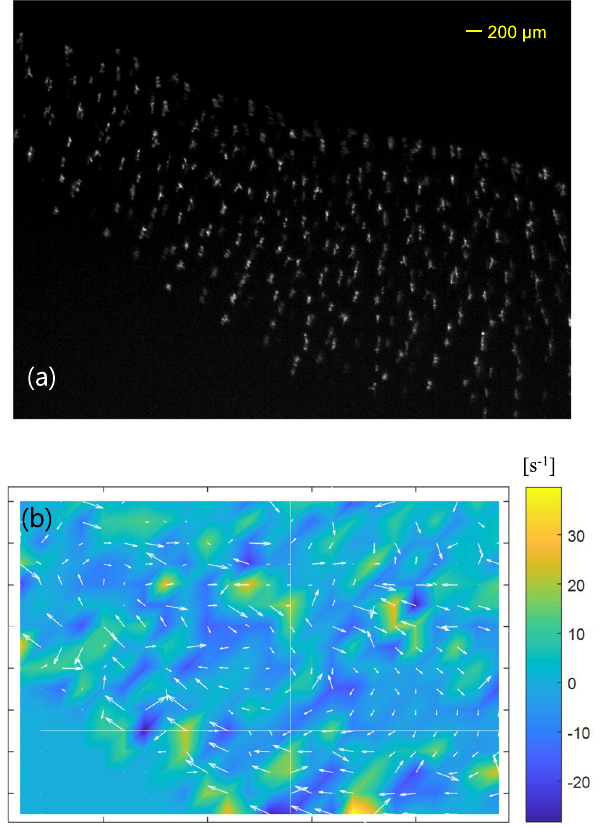
Figure 5. Vortex motion of nonspherical water-ice particles in a plasma. ( a ) Vortex motion of nonspherical particles. The camera recorded the upper-left corner of the plasma. The exposure time was 0.5 ms. While water- ice particles swirl, the alignment of nonspherical particles does not break up but the alignment angle slightly changes to be perpendicular to the cloud edge. In addition, nonspherical particles rotate about their alignment axis while they show vortex motion. ( b ) Velocity vectors (white arrows) obtained by an open source particle image velocimetry (PIV) analysis 28 . The length of vector corresponds to the speed of vortex flow. The color code represents the curl of the vortex velocity. Here, the cylindrical coordinate is used and so the positive means the direction out of the